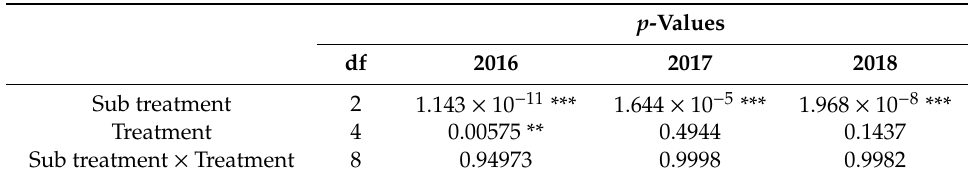
Table 7. p -values from two factor analysis of variance for treatments TT 0 –TT 4 and sub treatments T 0 –T